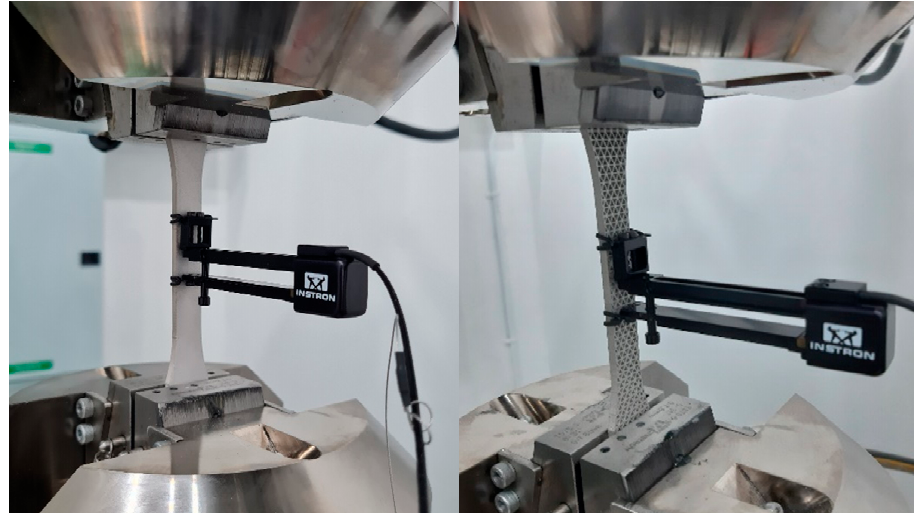
Figure 4. Set up of tensile test with an extensometer.